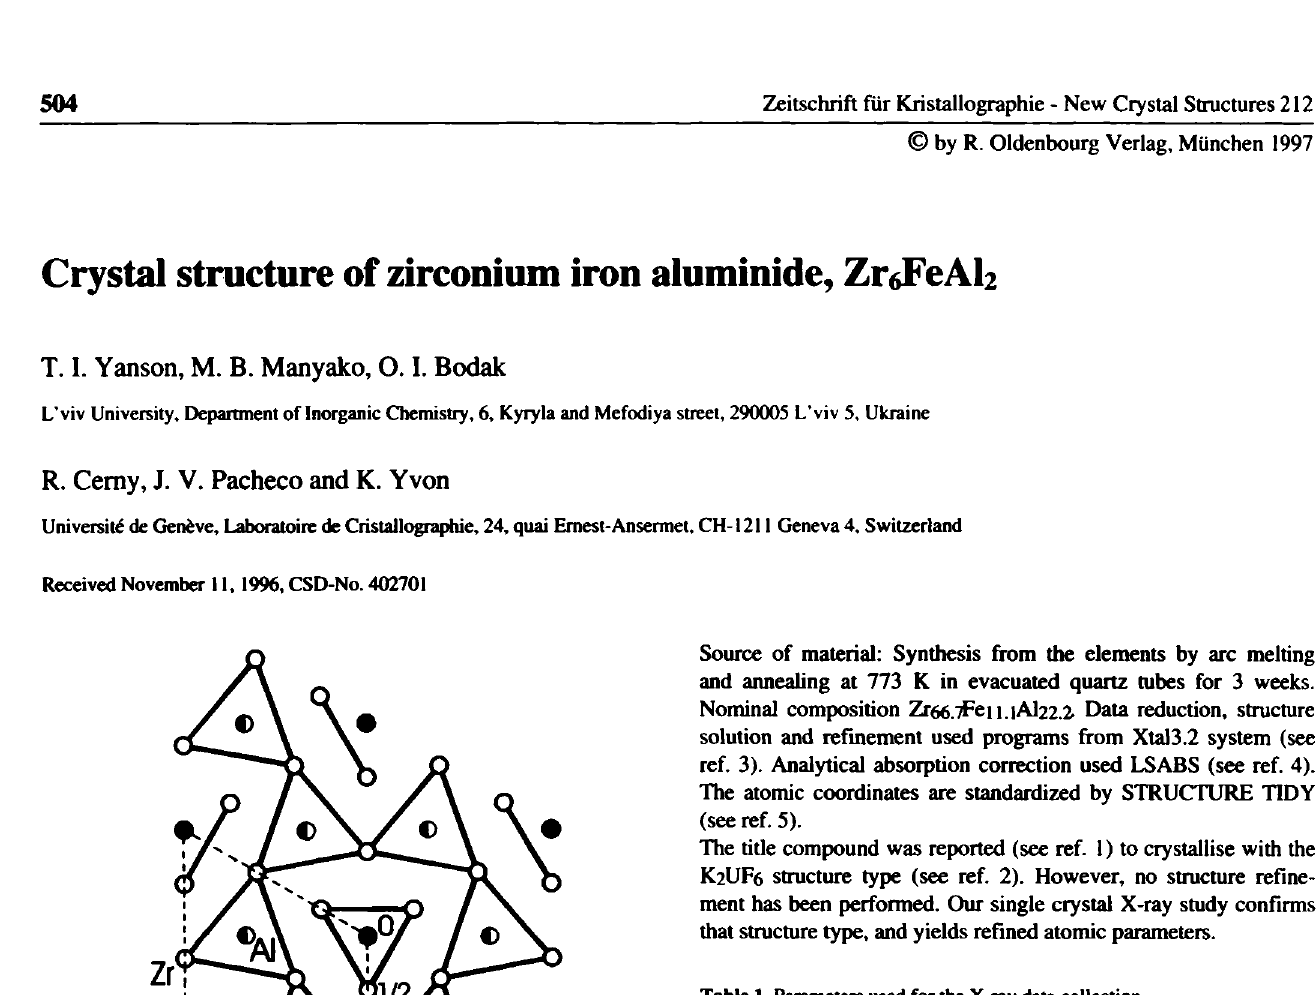
Table 1. Parameters used for the X-ray data collection Crystal: